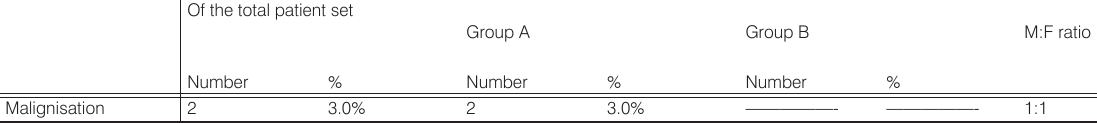
Table 5. Malignisation in the total patient set; (M: male; F: female)